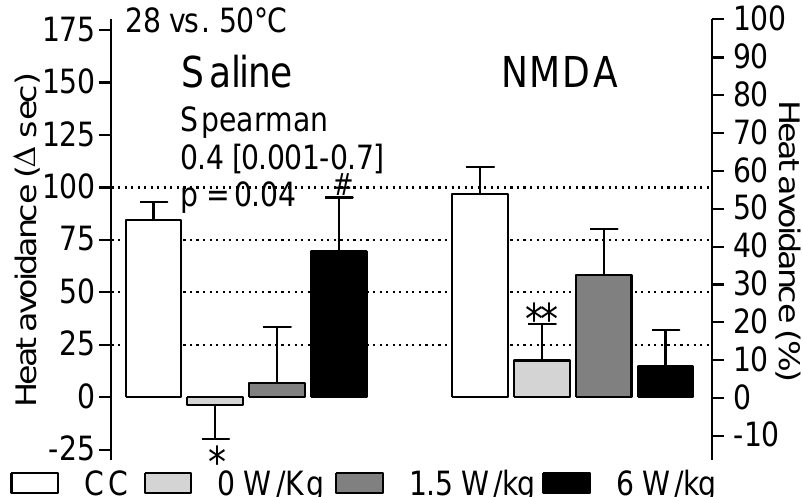
Figure 3. BASAR-dependent increase of heat avoidance (Δ 28–50 °C sec) during the first test. Sham-exposed and RF-EMF-exposed groups were tested in the two-temperatures choice test following i.t. saline or NMDA injection. * p < 0.05, ** p < 0.01 restraint significantly abolished heat avoidance. # p = 0.01, heat avoidance increased with the BASARs in the saline treated rats but not in the NMDA-treated rats. N = 6–12 rats/group.